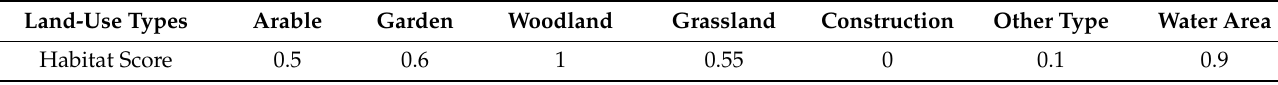
Table 4. Habitat suitability of each land use/land cover